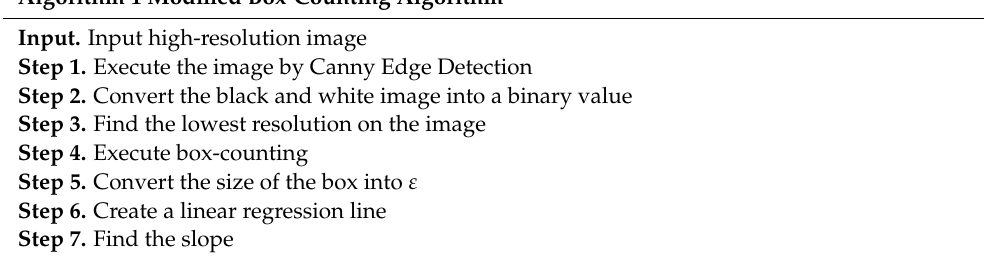
Algorithm 1 Modified Box-Counting